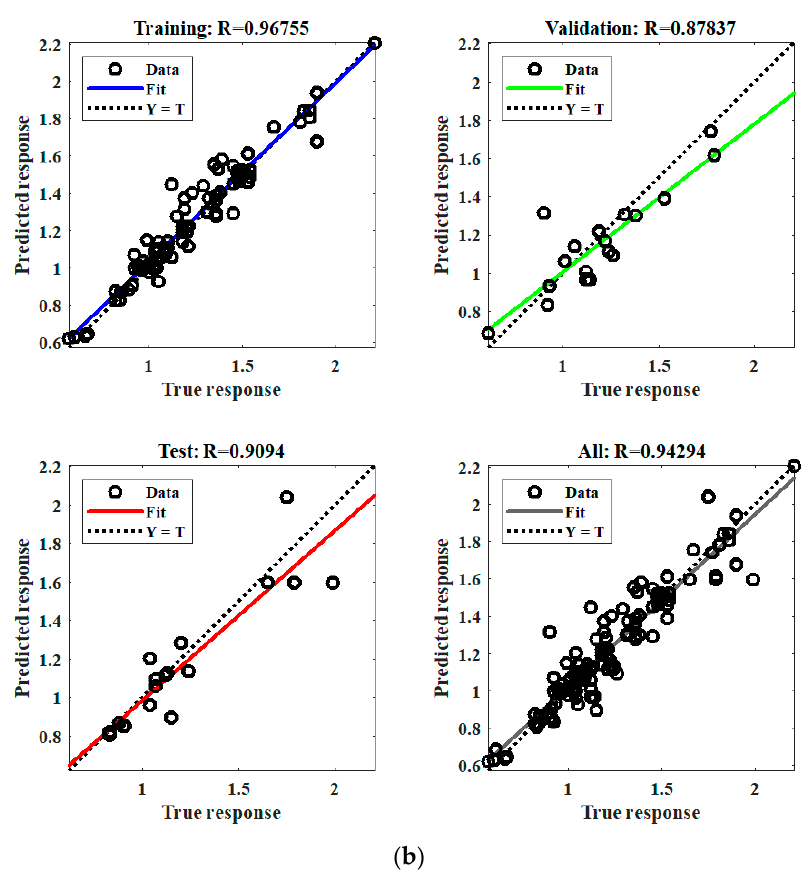
Figure 8. Validation and testing sets: ( a ) MSE vs. iteration epochs and ( b ) predicted response vs. true response.